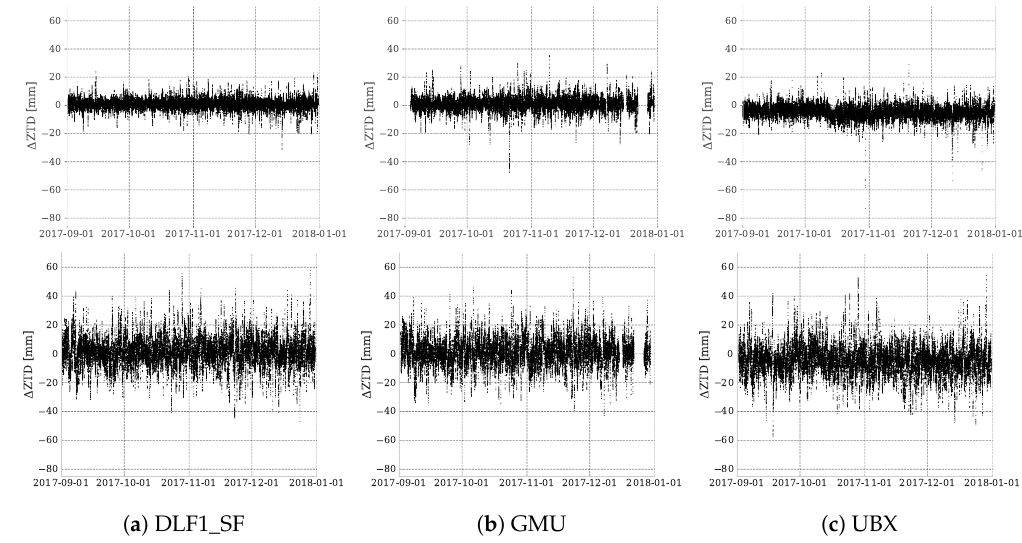
Figure 5. ZTD differences between the goGPS-processed dual-frequency reference dataset and the SEID-processed single-frequency estimations DLF1_SF, GMU, and UBX. The figures at the top depict the DPGA SEID constellation results, whilst the ones on the bottom are from the EUREF SEID constellation, respectively. DLF1_SF ( a ) is the synthesized single-frequency dataset obtained from the IGS stations DLF1. GMU ( b ) and UBX ( c ) are the two cost-efficient single-frequency receivers utilizing different antenna types but sharing the same receiver type. A comparison period of 1 September–31 December 2017 was selected since all receivers provide observations during this period.